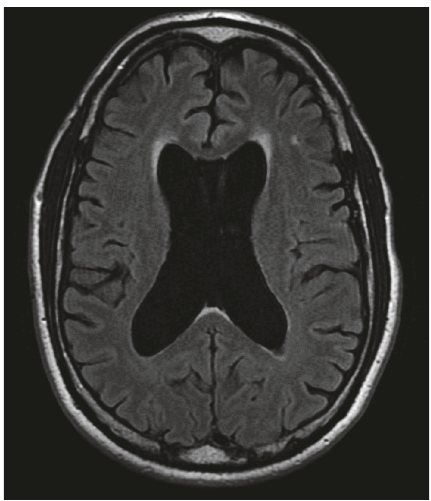
Figure 1: MRI reveals changes related to possible CTE . Axial image reveals both cortical and subcortical atrophy, enlarged lateral and third ventricle, and cavum septum